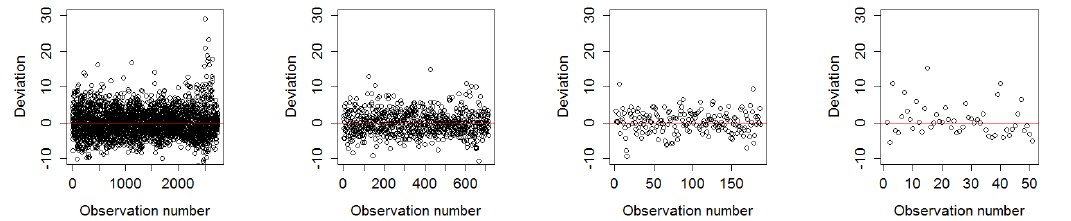
Figure 9. Deviation of residuals around the mean of 1988 in all four resolutions as worst model fit.